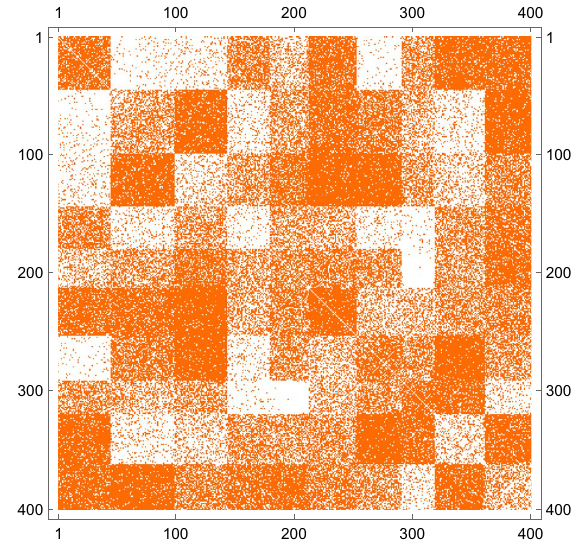
In comparision, the RD method finds the correct structure without a single error